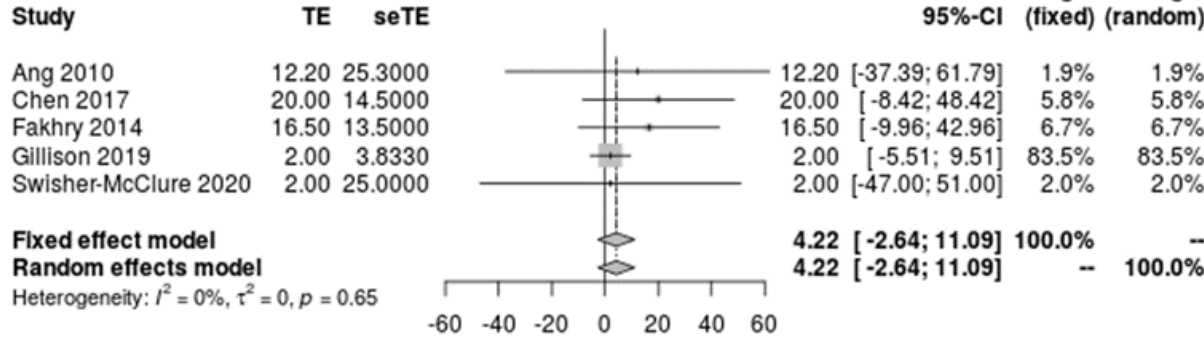
Figure 3. Meta-analysis of single means for participant pack years.